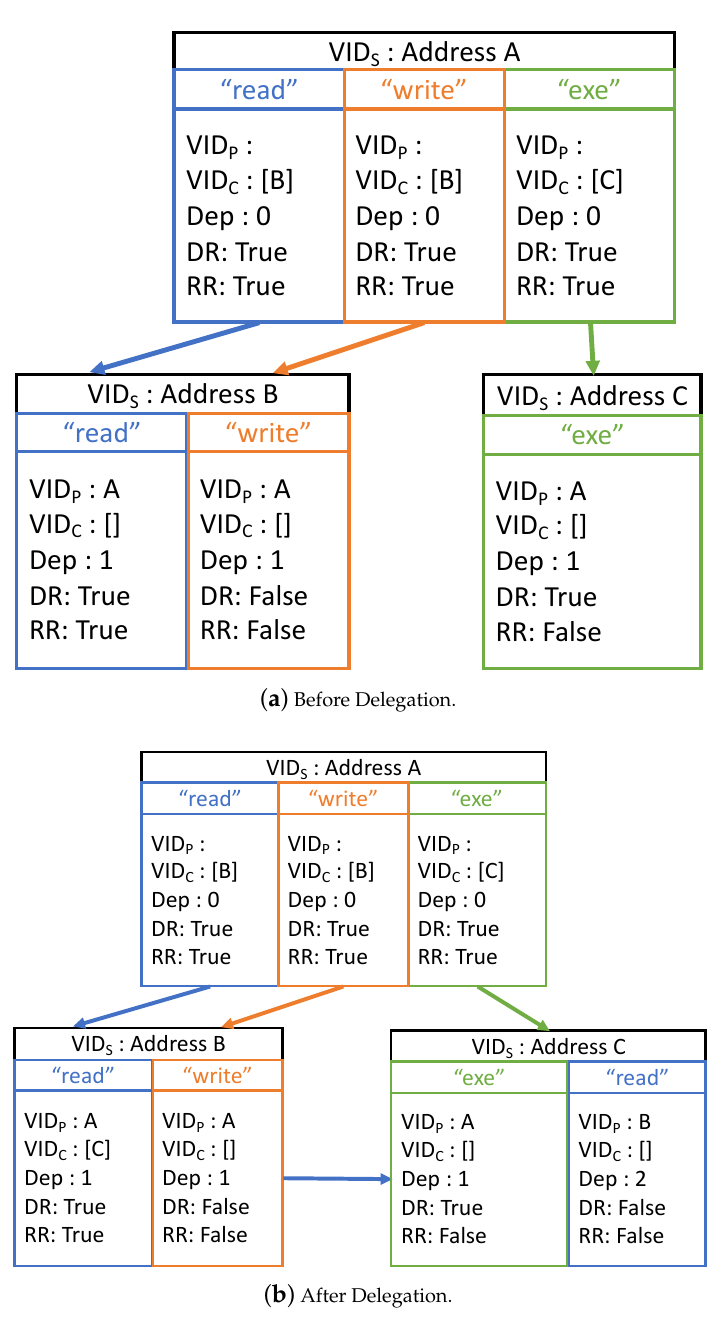
Figure 4. Delegation Graph of the Proposed CapBAC